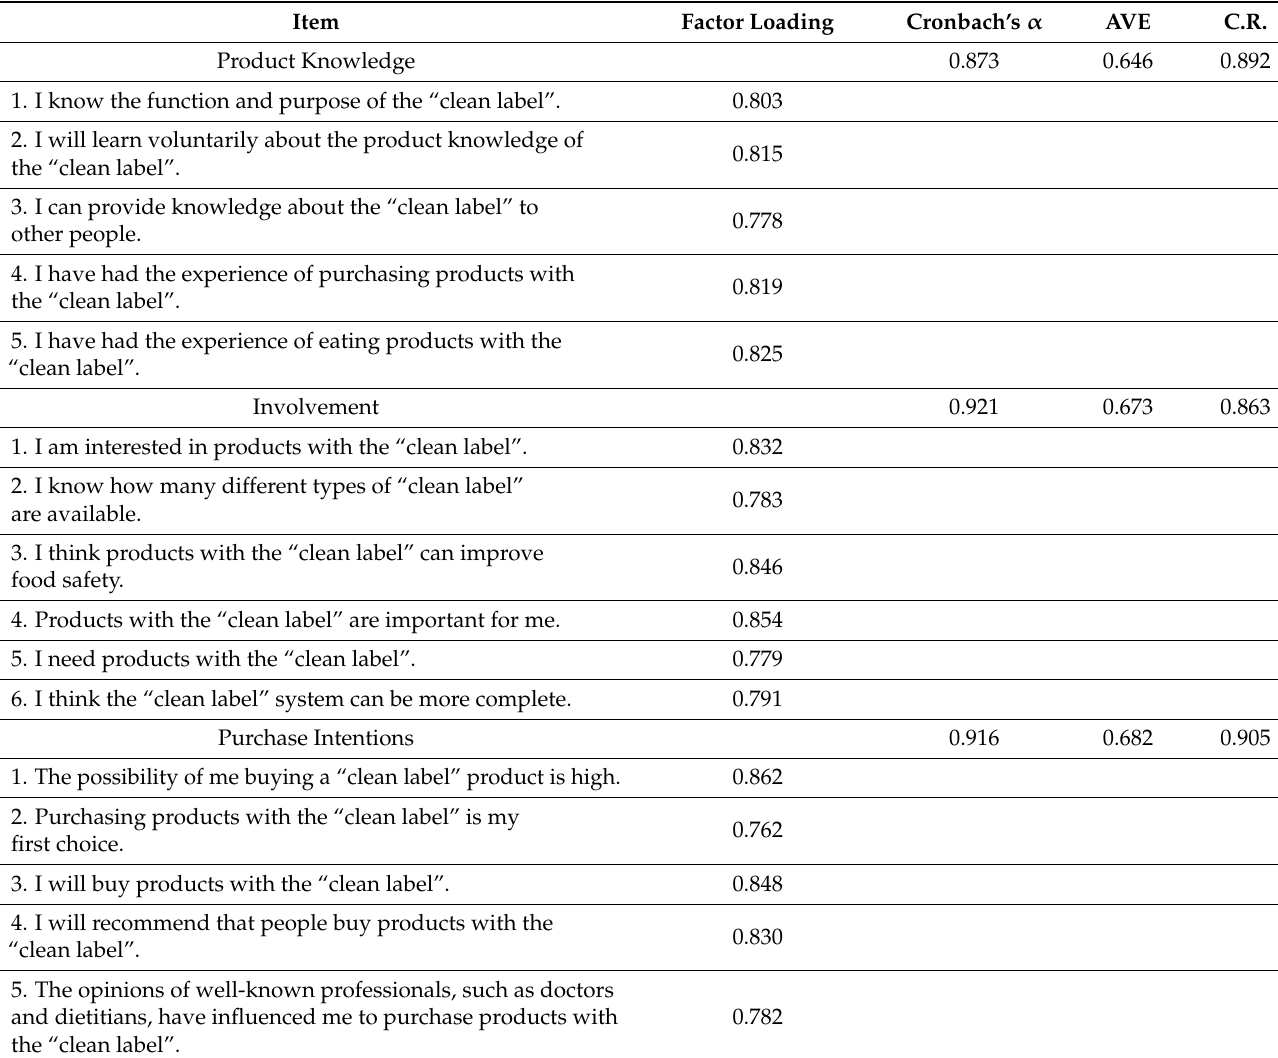
Table 1. Results for factor loading, reliability, and